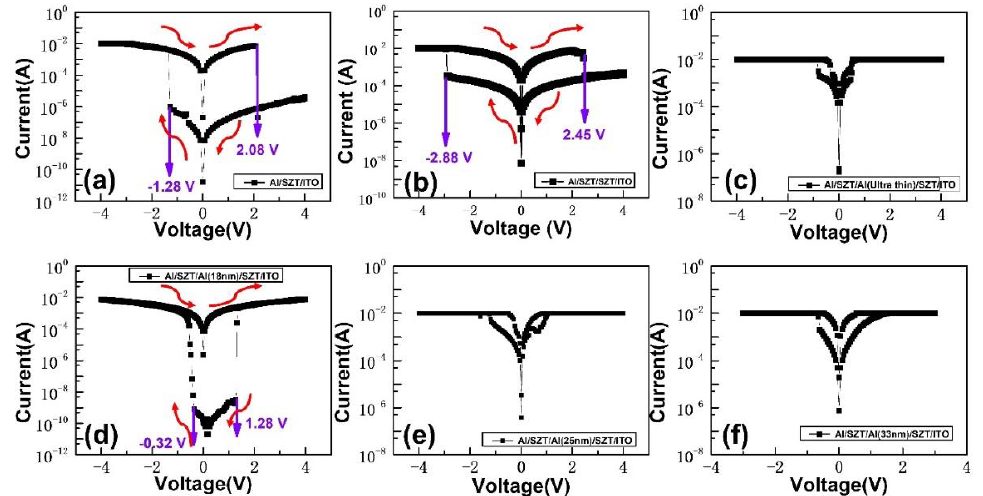
Figure 4. I – V switching curves of ( a ) Al/SZT/ITO, ( b ) Al/SZT/SZT/ITO, and ( c – f ) Al/SZT/different thicknesses (5, 18, 25, and 33 nm) of embedded metal – Al /SZT/ITO device RRAMs.